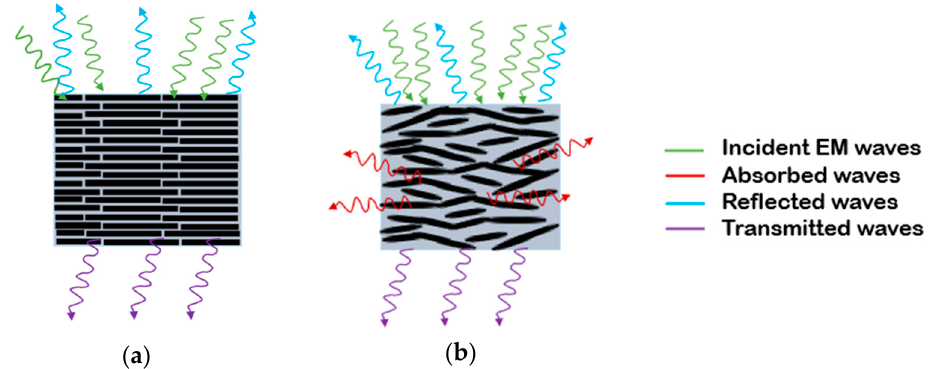
Figure 7. Schematic representation of ( a ) aligned/compact (i, ii) and ( b ) chaotic/porous (iii, iv) nanoarchitecture.